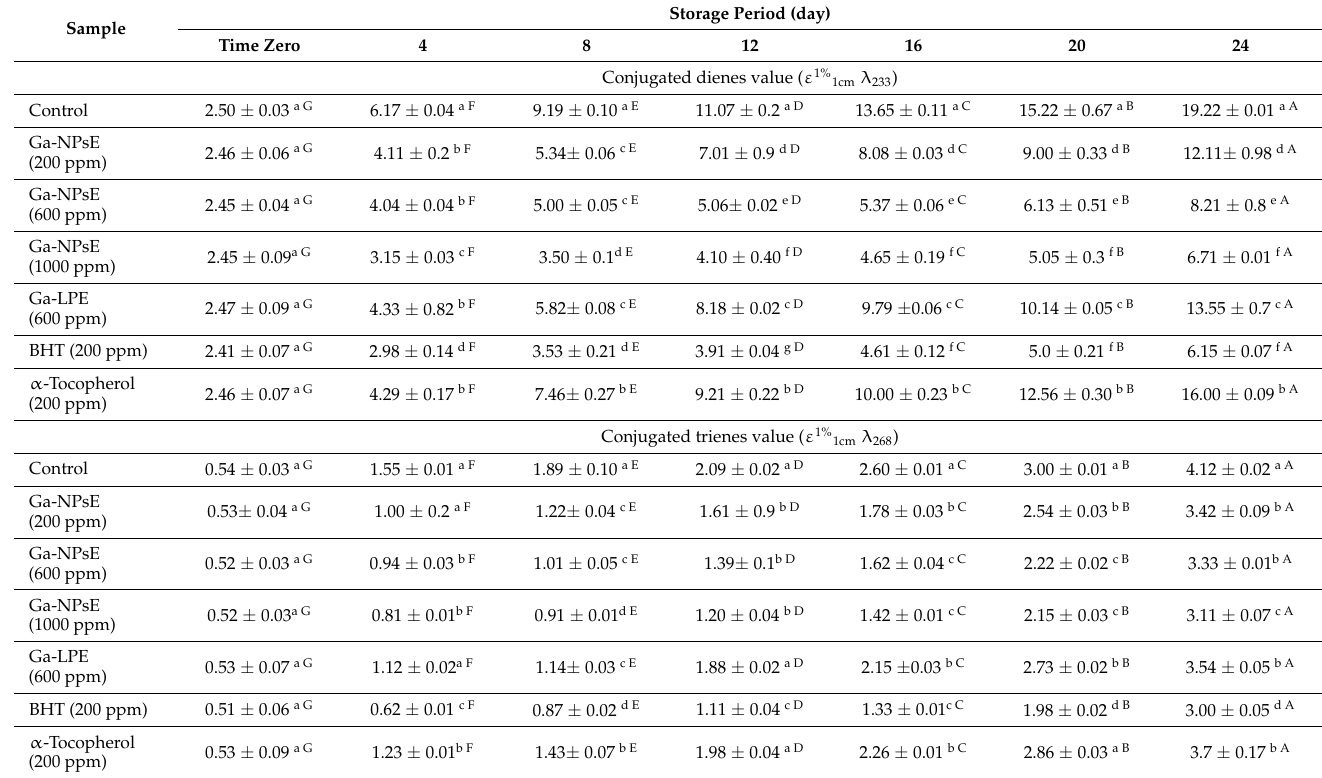
Table 4. Effect of garlic nanoparticle extracts on conjugated dienes and conjugated trienes of SFO during storage at 65 ◦ C (mean ± SD, n =